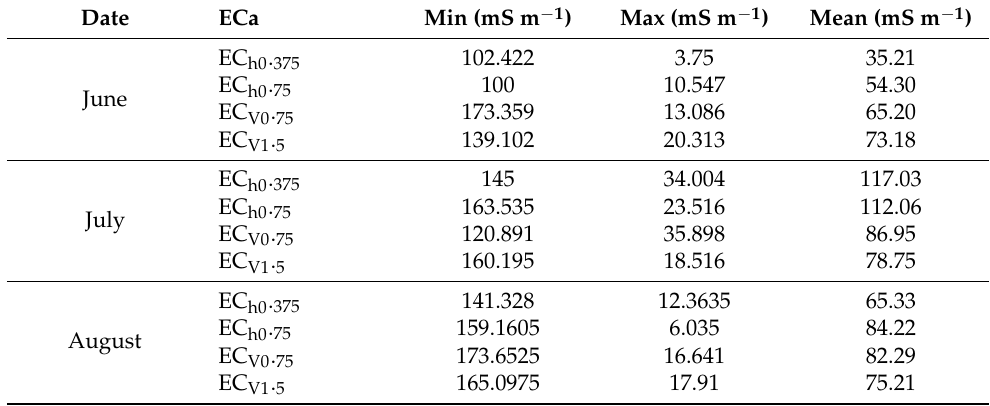
Table 4. The statistical characteristic values of geospatial electromagnetic induction measurements of apparent electrical conductivity (ECa) at different